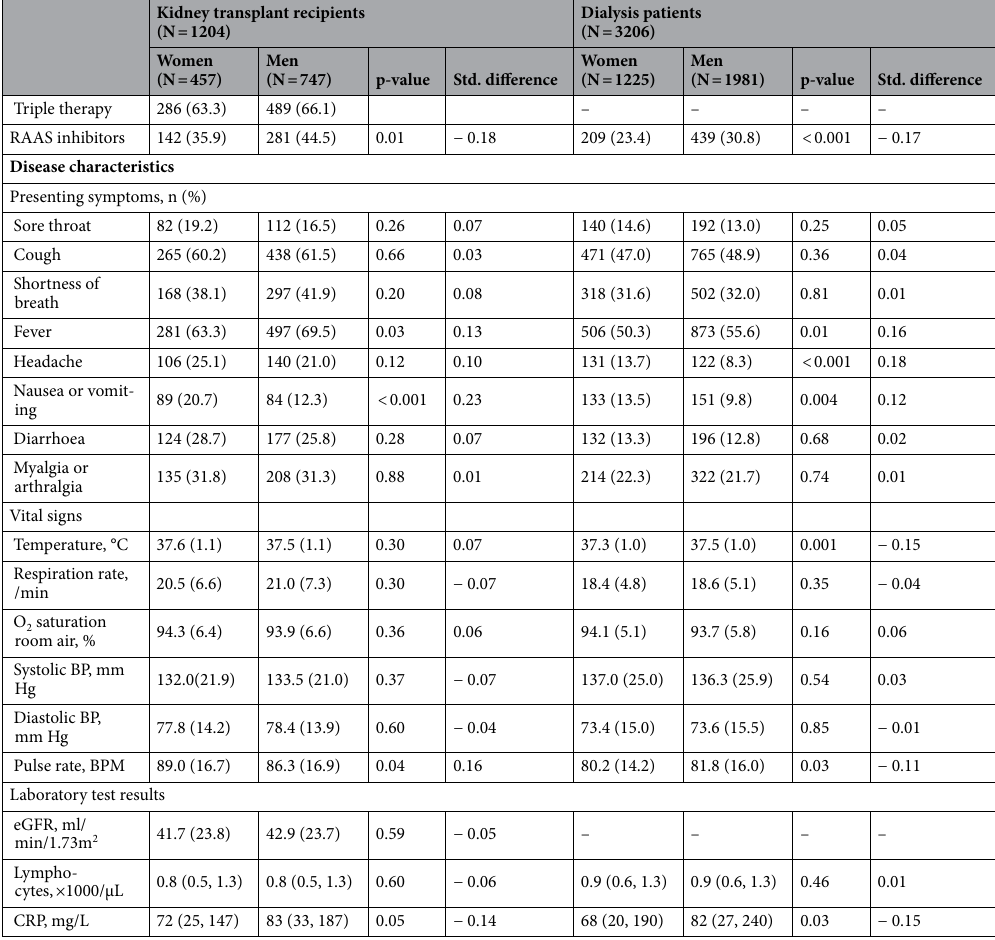
Table 1. Baseline characteristics by sex in kidney transplant recipients and dialysis patients with COVID-19. Continuous variables are reported as mean (standard deviation) or median Interquartile interval). Groups were compared using independent sample t-test, Mann–Whitney U-test, or Pearson Chi-square test as appropriate. Obesity is defined as BMI > 30 kg/m 2 . Std., standardized; °C, degree Celsius; O 2 , oxygen; BP, blood pressure; BPM, beats per minute; eGFR, estimated glomerular filtration rate; CRP, C-reactive protein; RAAS = Renin– angiotensin–aldosterone system. a Total number may not add up due to missingness (126 missing in kidney transplant recipients, 751 missing in dialysis patients). b In those